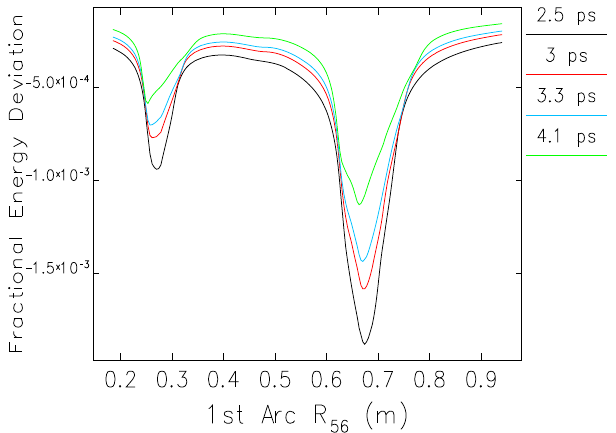
FIG. 5. Comparison of energy loss due to CSR in simulation for several different initial bunch lengths. The nominal bunch length value used in the simulations is 3.3